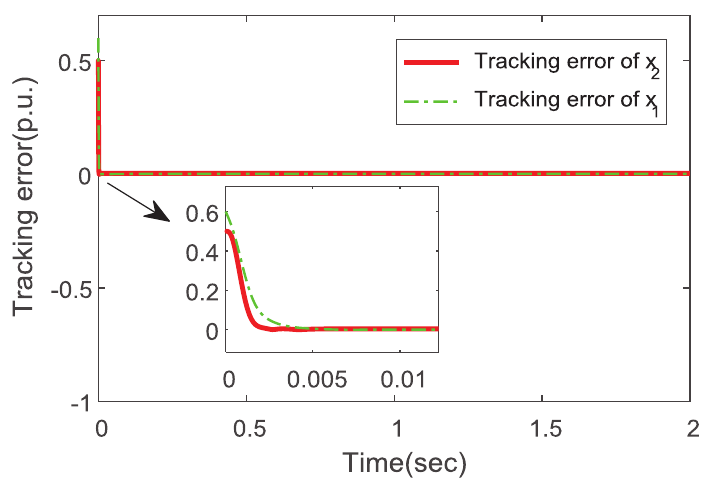
Figure 11. x 2 and x 2 d under the method proposed in this paper.